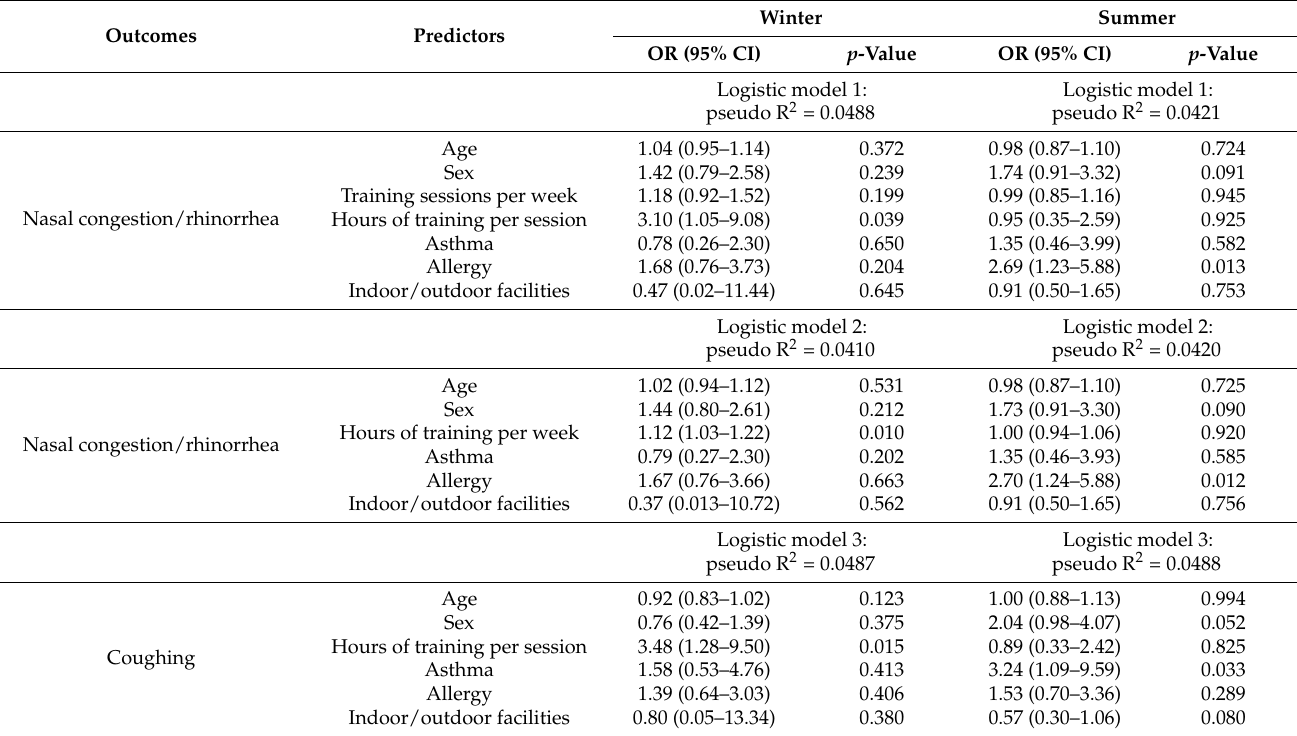
Table 3. Results of multiple logistic regression